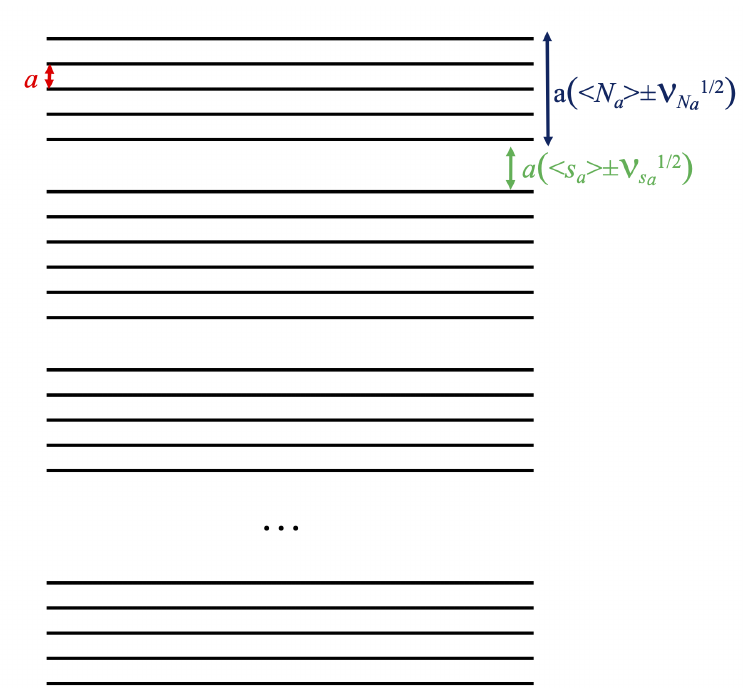
Figure 2. This is a representation of a system with 1D SDE. It consists of a stacking of parallel planes, sub-ordered in bunches of different height. Planes (orthogonal to the figure) are represented by their traces; the vertical direction is the stacking direction, normal to the planes. The spacing between planes in a bunch is a , inter-bunch spacing a that on average is (cid:104) N a (cid:105) with a dispersion V 1/2